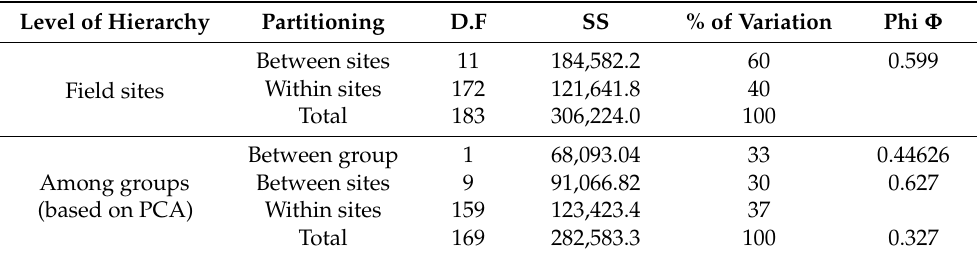
Table 1. Results from the Analysis of Molecular Variance for A. purpuereopetala SNP data. Two hierarchical levels were analysed: at the field site level and among groups (green and purple groups as based on the results from the PCA illustrated in Figure 2). d.f degree of freedom, SS = Sum of squares, Phi-statistics ( Φ ) according to [55].